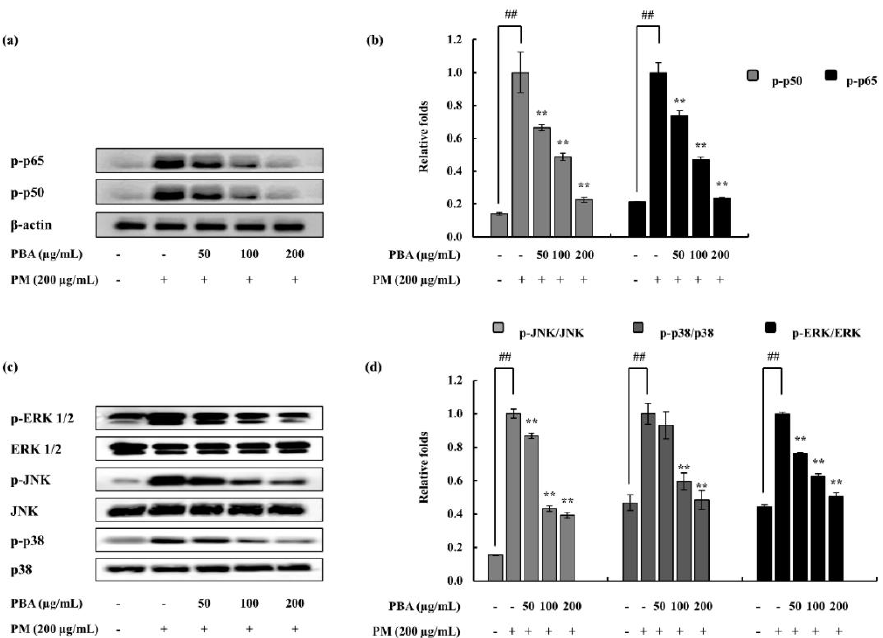
Figure 5. PM-induced HDF cells and co-treatment with PBA. ( a ) p50 and p65 in the cytosol, ( c ) p38, JNK, and ERK, data determined using Western blotting. Quantitative data were analyzed using ImageJ software ( b , d ). Results are expressed as the mean ± SD of three separate experiments. * p < 0.05 and ** p < 0.01. (# denotes significance compared to control while * represents significance compared to PM treated group). Table 2. Metal composition analysis.